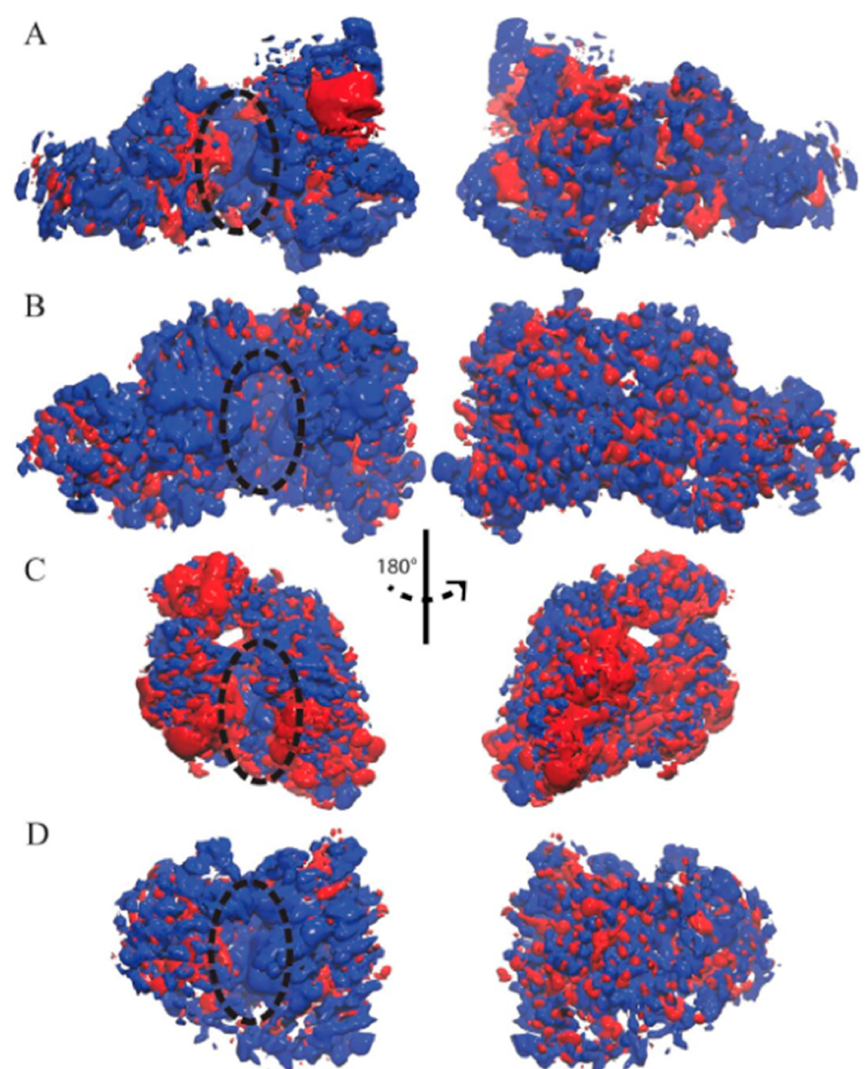
Figure 3. Ensemble-averaged electrostatics of ( A ) TbRET1; ( B ) TbRET2; ( C ) TbMEAT1; ( D )